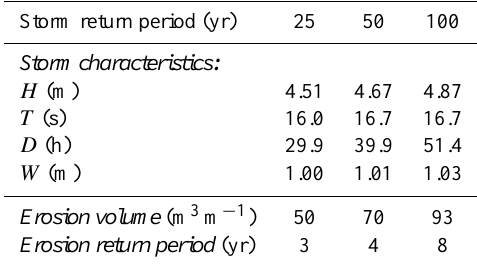
Table 2. The most-likely design realizations for multivariate return periods 25, 50 and 100yr and the associated erosion return